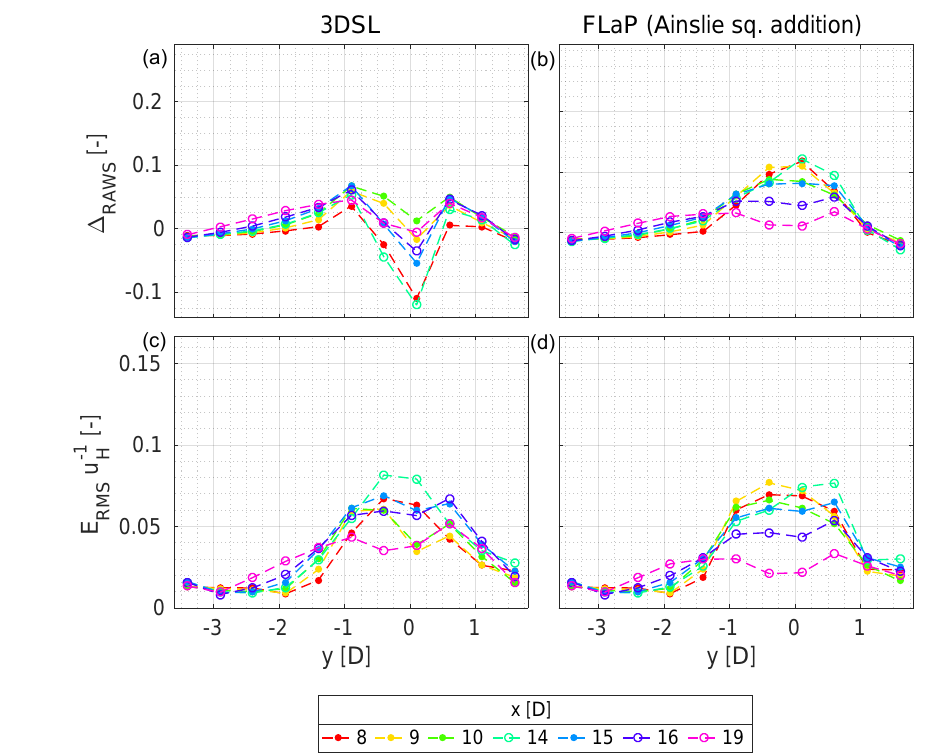
Figure 7. Test case 2 (multiple aligned wakes). Deviation of the rotor-average wind speed (cid:49) RAWS (a, b) and of the root mean square error E RMS /u H (c, d) evaluated in relation to the large-eddy simulation wind field for the simulation with the 3DSL model and with FLaP.